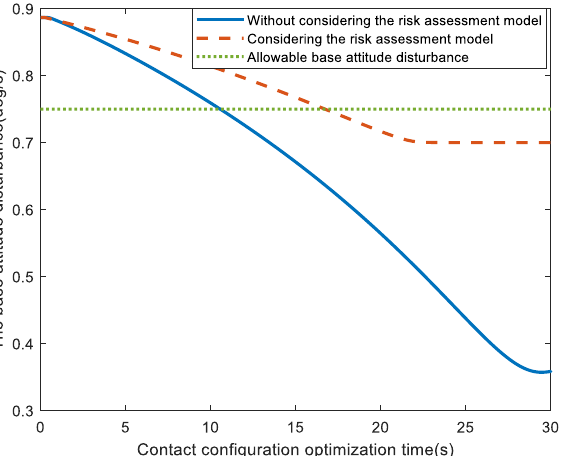
Figure 14. The optimization of the base attitude disturbance with and without considering the risk assessment model.